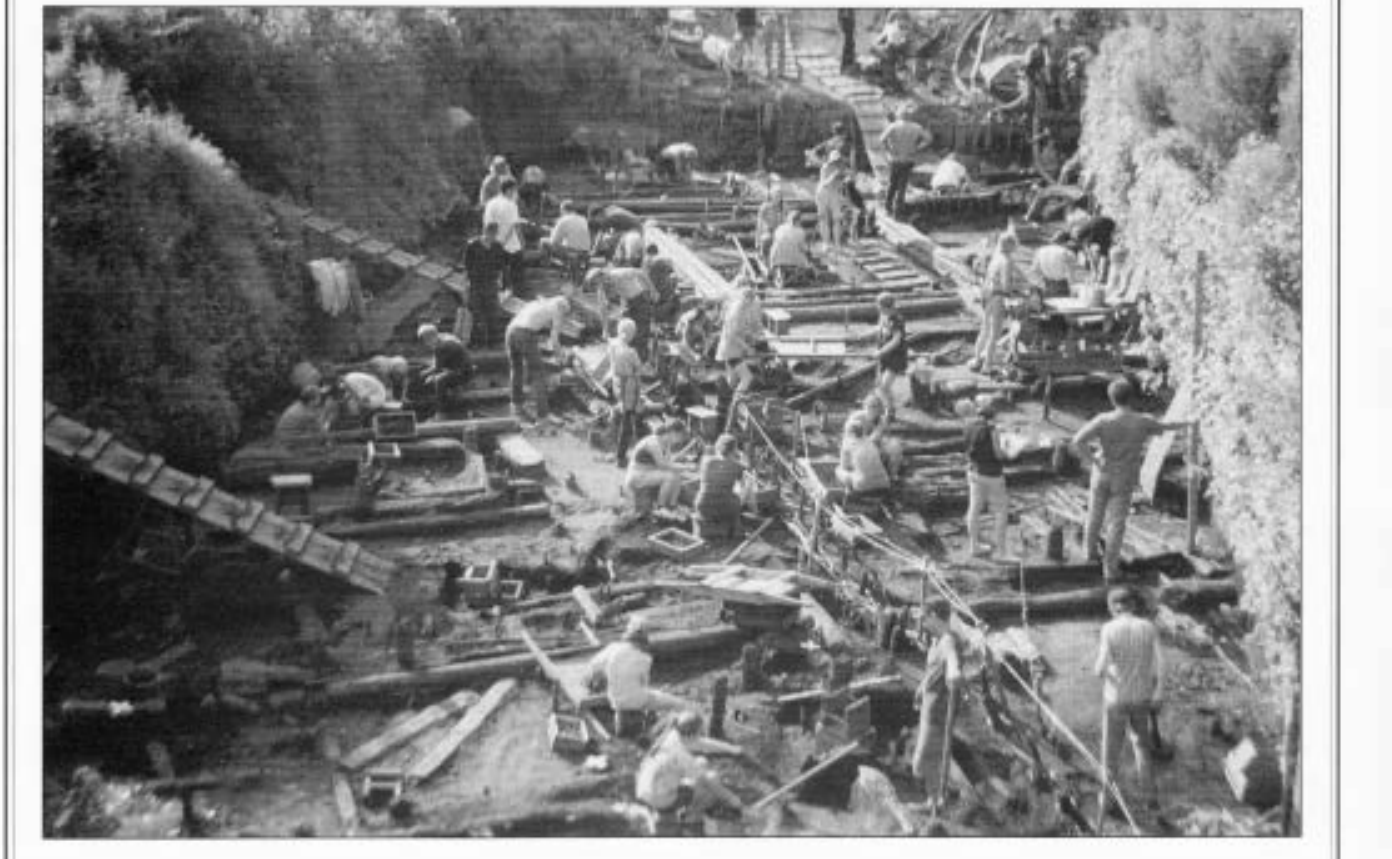
Figure 1 Excavation of late tenth-century houses under way at the Troitsky XI site, 1998; view from the